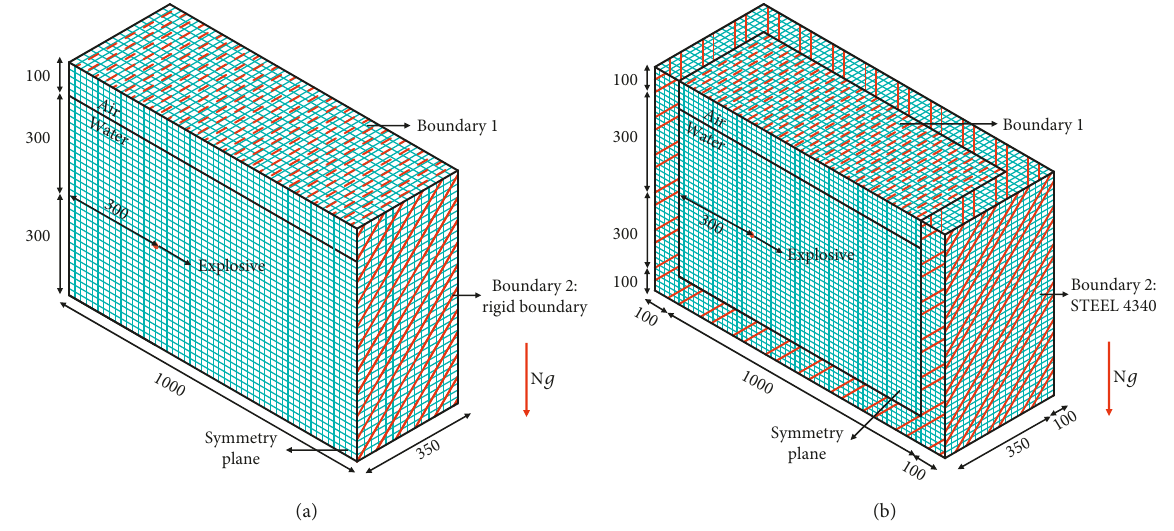
Figure 6: Three-dimensional numerical models of underwater